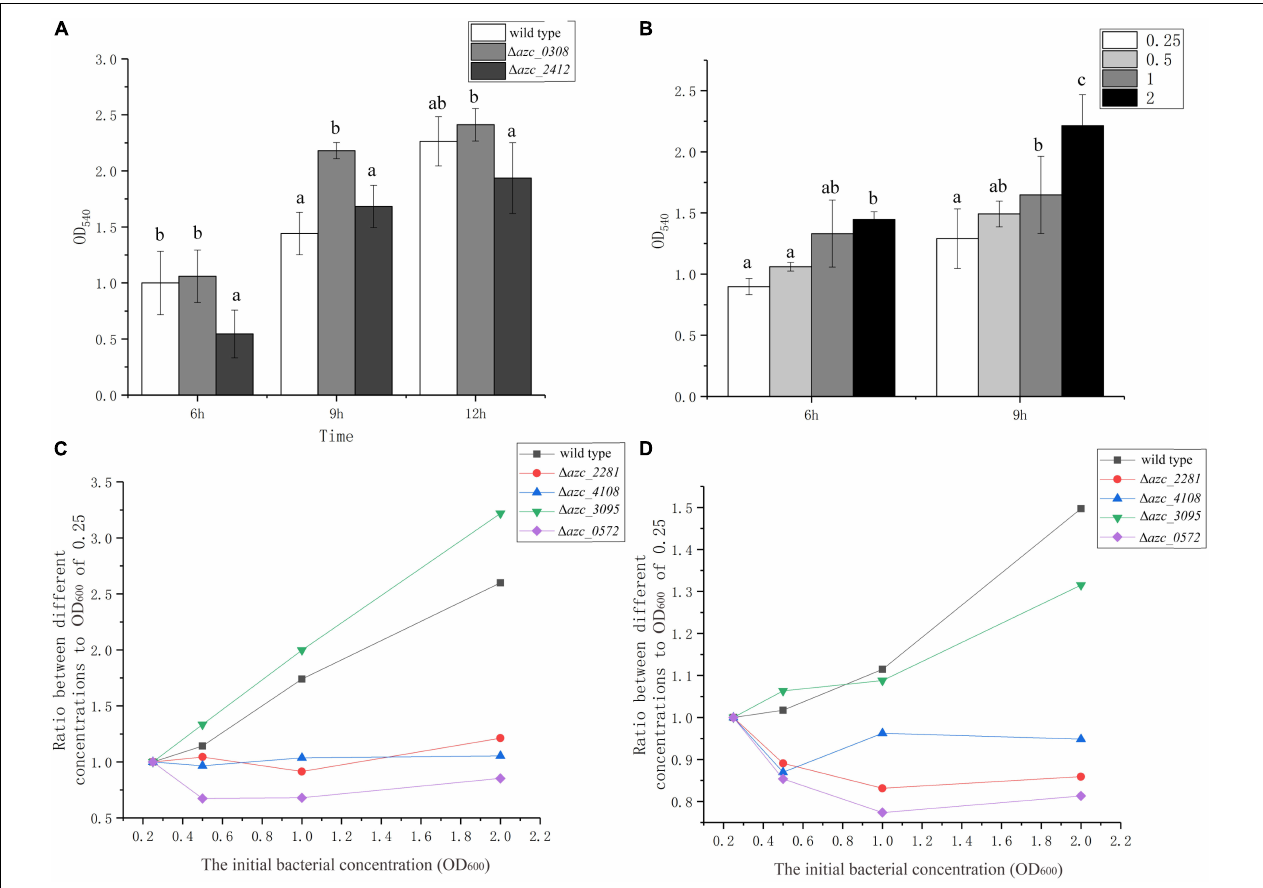
FIGURE 5 | The role of c-di-GMP and quorum sensing on biofilm formation. (A) Biofilm formation of c-di-GMP increased and decreased mutants, (cid:49) azc_0308 and (cid:49) azc_2412 after 6, 9, and 12 h. (B) Biofilm formation of wild type with different initial bacterial concentrations from OD 600 of 0.25 to 2.5 after 6 and 9 h. (C,D) The relationship between the biofilm biomass and initial bacterial concentration for different quorum sensing luxR -like gene mutants, (cid:49) azc_0572 , (cid:49) azc_2281 , (cid:49) azc_3095 , (cid:49) azc_4108 after 6 h (C) and 9 h (D) . Values are shown as the means and standard deviations from at least three independent experiments. The same letter above the error bars indicates not statistically different with results under same culturing time by a Duncan’s